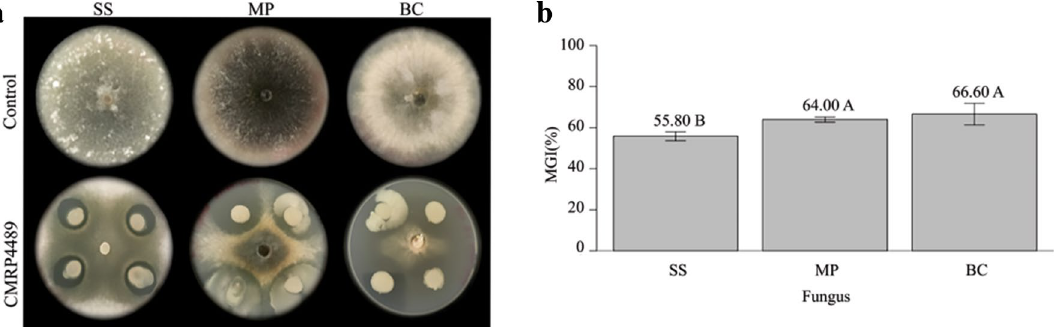
Figure 1. Dual-culture assay of B. velezensis CMRP 4489 and Sclerotinia sclerotiorum (SS), Macrophomina phaseolina (MP), and Botrytis cinerea (BC). ( a ) Photograph of the dual-culture test with the experimental